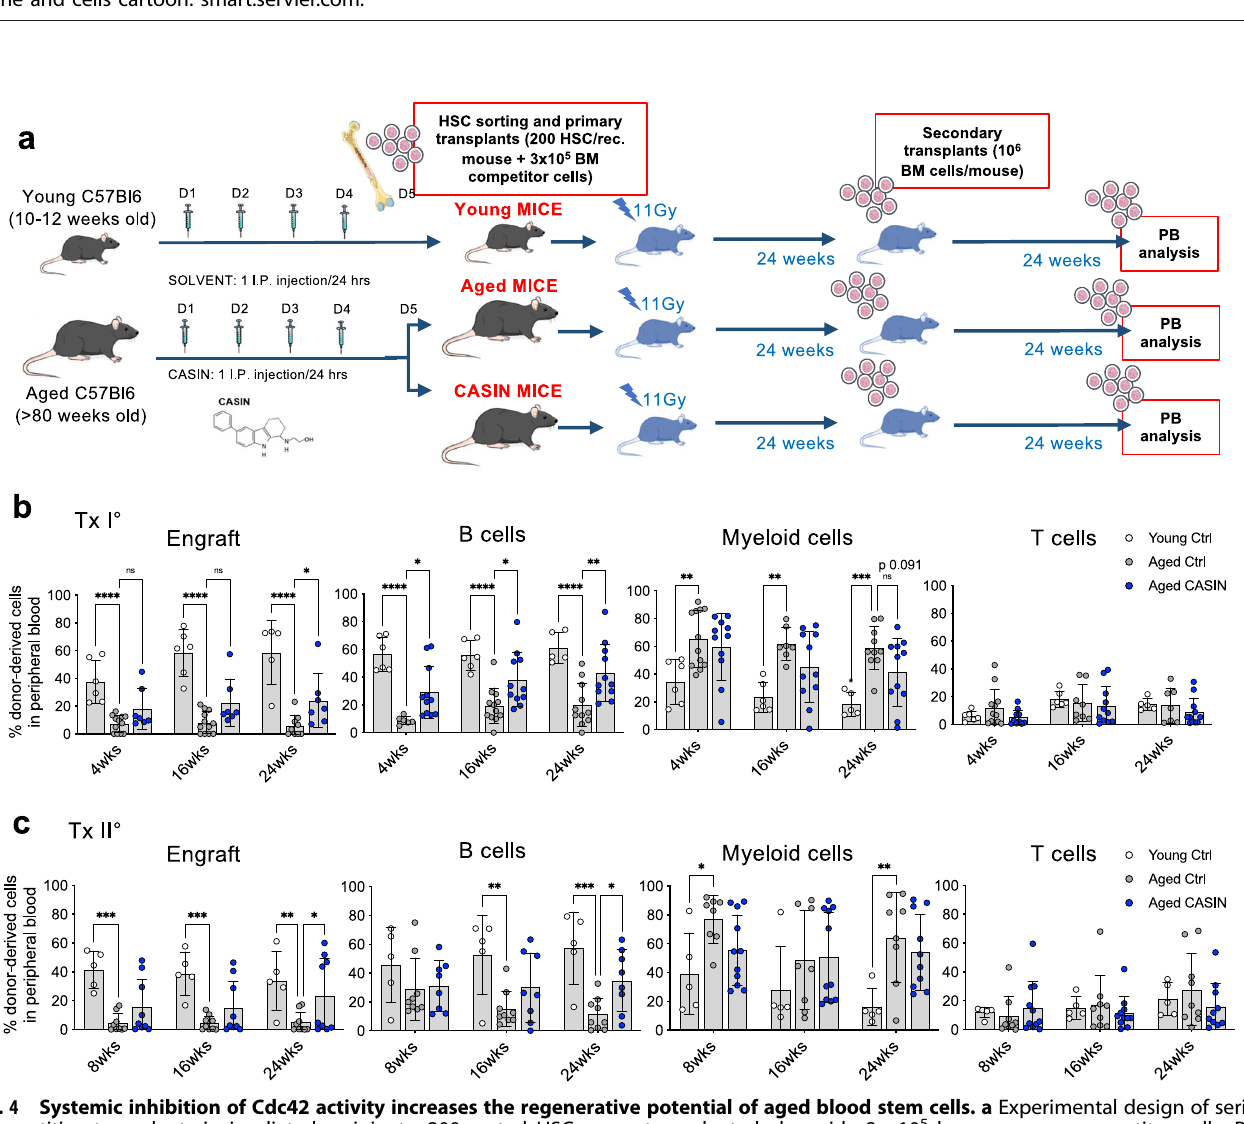
Fig. 3 Systemic inhibition of Cdc42 activity increases hematopoietic stem cell (HSC) polarity and restores stem cell localization in BM of aged mice. a Experimental design. b Representative IF images of single FACS-sorted HSCs from young, aged, and CASIN mice stained for Cdc42 (red), tubulin (green) and the nucleus (DAPI, blue). Scale bars, 10 µm. c IF quanti fi cation of the percentages of HSCs polar for Cdc42 and tubulin ( n = 4). Columns are mean ±SD. d Histological analysis of H4K16ac polarity in HSCs (arrowed). Scale bars, 20 µm. e Quanti fi cation of the percentage of HSCs polar for H4K16ac in young, aged, and CASIN mice ( n = 3). Columns are mean ±SE. f Histological analysis of HSC proliferation rate by Ki67 staining. Scale bars, 20 µm. g Quanti fi cation of the percentage of HSCs Ki67 − and Ki67 + ( n = 3). 203, 374, and 371 total HSCs for young, aged, and CASIN respectively were analyzed. h Quiescent HSC proximity to arteries in young, aged and CASIN mice. Scale bars, 35 µm. i Quanti fi cation of the minimum distance of HSCs to the closest artery, sinusoid, and endosteum ( n = 3). Values are median with 95% CI. Columns are mean ±SE. * P < 0.05, ** P < 0.01, *** P < 0.001 and **** P < 0.0001; one-way ANOVA, multiple comparisons with Tukey test for c , e ; Mann – Whitney test two tails for i . Source data are provided as a Source Data fi le. Mouse cartoon: CreativeBucket:stock.adobe.com. Bone and cells cartoon: